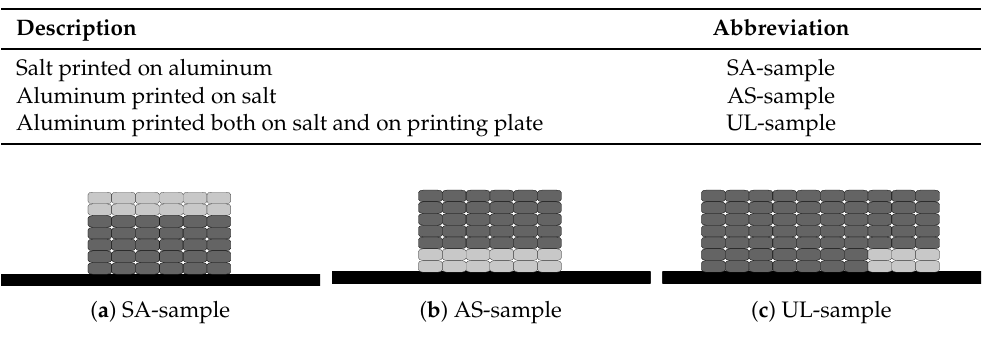
Table 2. Sample geometries.